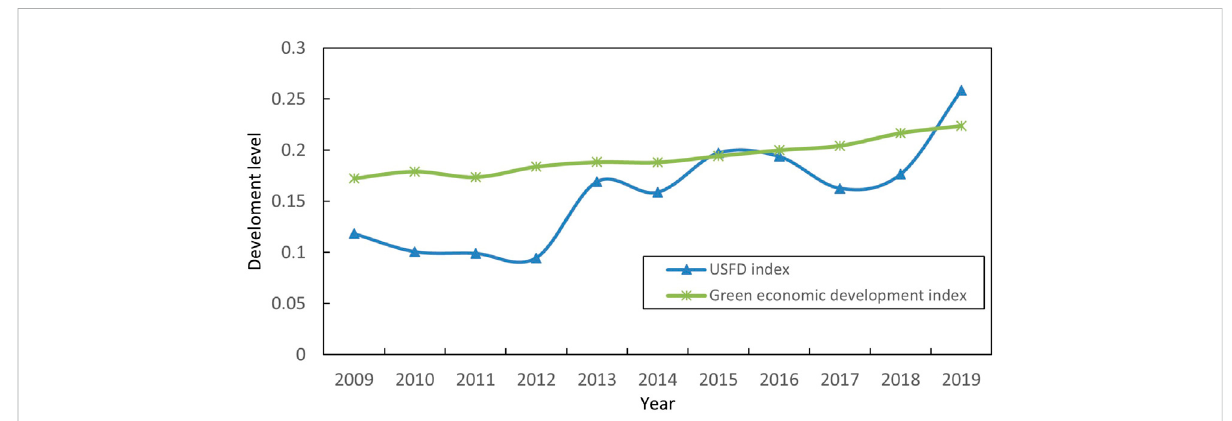
FIGURE 2 The level of USFD and green economic development in the YREB from 2009 to 2019.